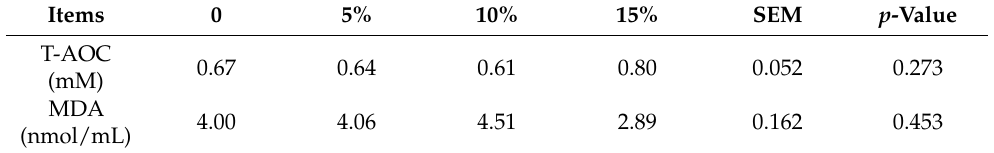
Table 8. The effect of adding fermented feed on the antioxidant property indexes of broiler serum.